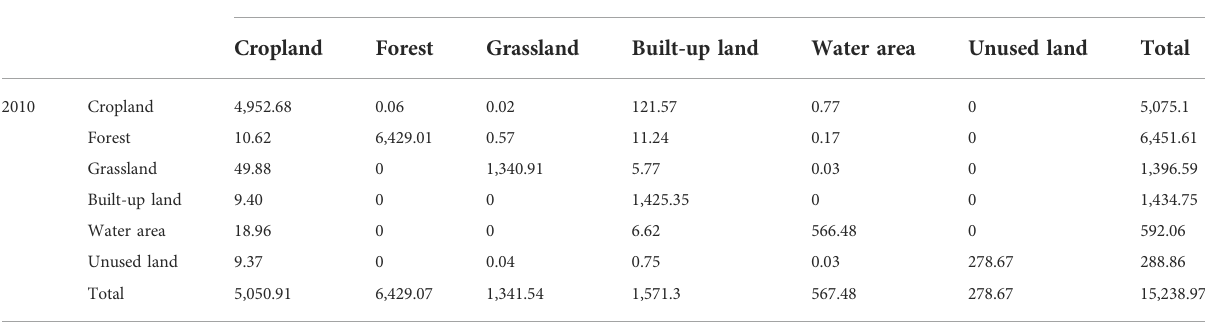
TABLE 3 2010 – 2015 Land Use Transfer Matrix (values in square kilometers).